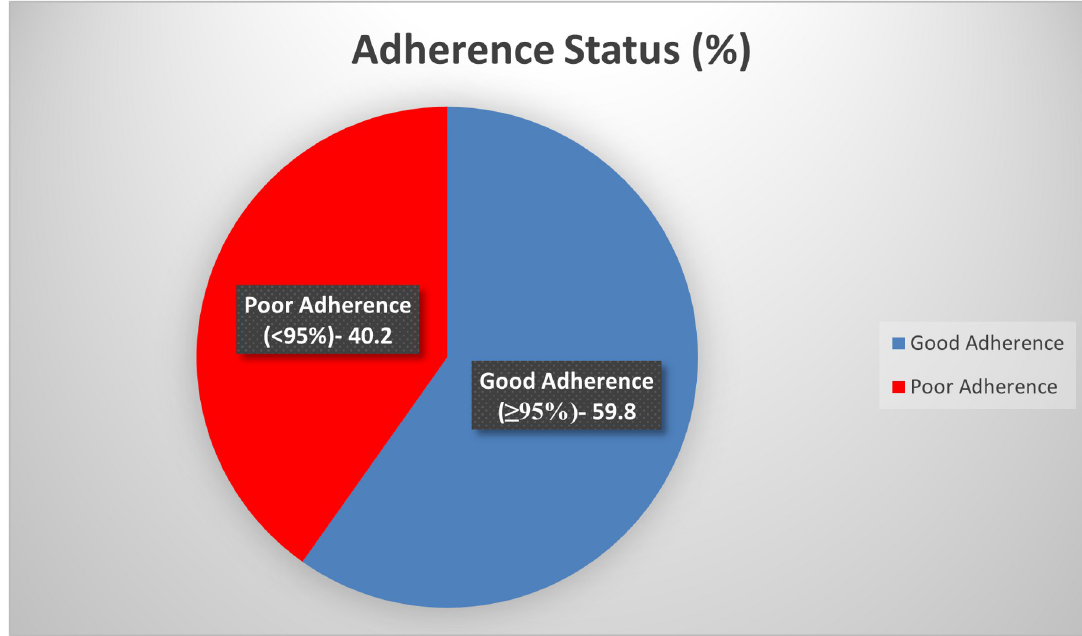
Fig 2. Overall level of ART adherence among children 1–14 years.